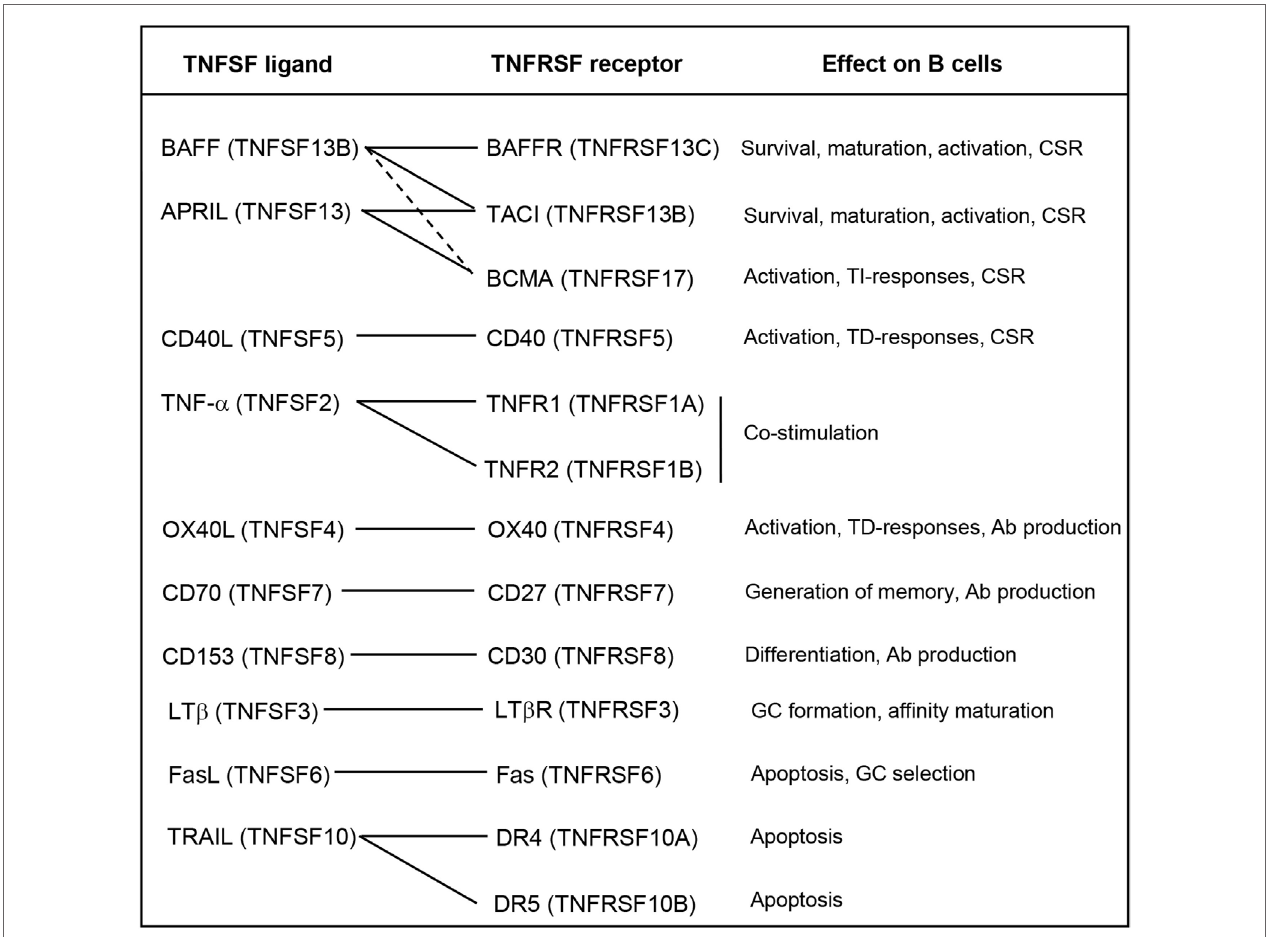
FiGURe 1 | Roles of the TNFSF on B cell functions. Known interactions between ligands and receptors are indicated with solid lines, or dashed lines if the interactions are of weak affinity. Abbreviations: Ab, antibody; CSR, class-switch recombination; GC, germinal center; TD, thymus dependent; TI, thymus